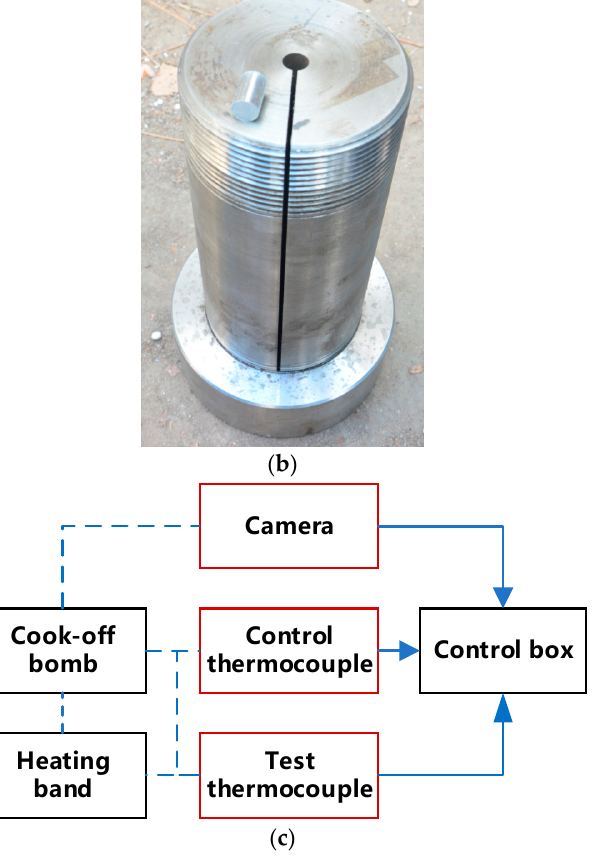
Figure 1. Cook-off experimental system. ( a ) Cross-section of cook-off bomb. ( b ) Sample and the shell of cook-off bomb. ( c ) Test flow chart. Table 2. Test conditions.